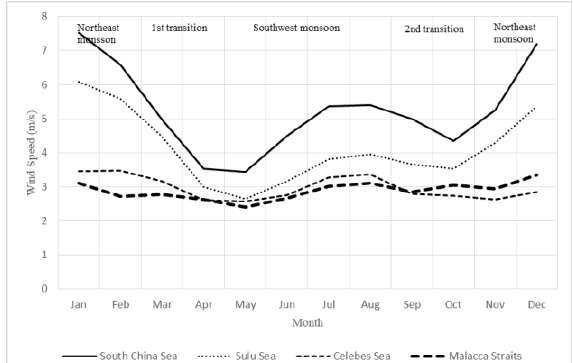
Figure 12. The trend-line of wind speed for each sea regions.